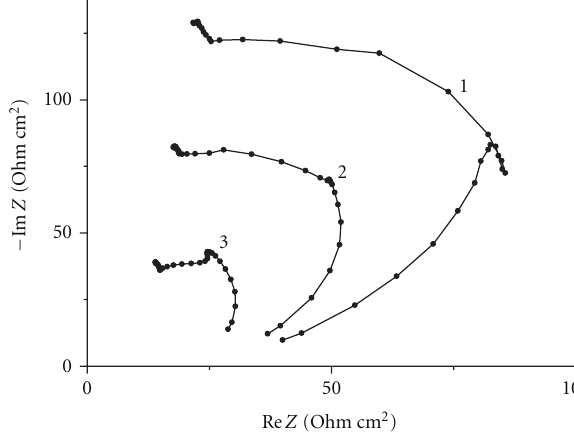
Figure 9: Complex-plane plots of impedance spectra ( E -sweep): (1) benzene-free solution and (2) benzene-containing solution. Arrows show the direction of potential sweep; the relevant potential values are shown at the curves.